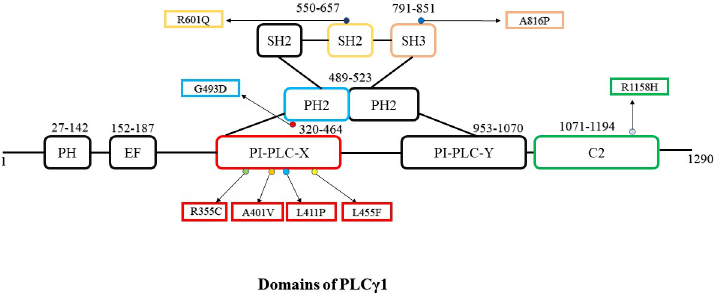
Fig 8. Domain organization with structural insights of PLC γ 1 protein (protein ID ENSP00000362368). The final 8 nsSNPs shortlisted for structural analysis are marked in their domain.